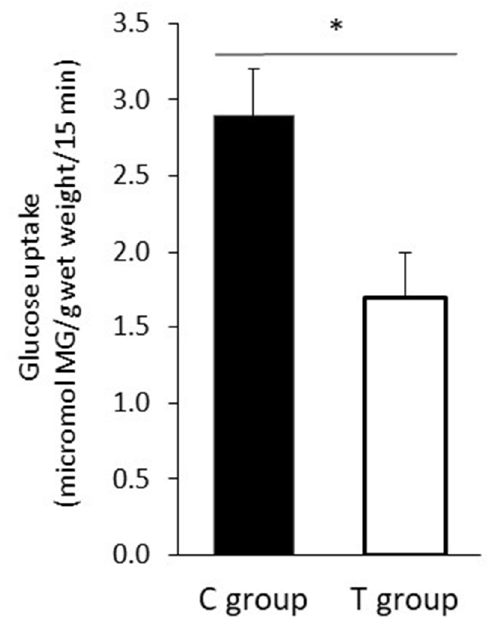
Figure 5. Intestinal glucose uptake. When intestinal glucose transport was determined, it was found that animals administered the FFP (T group) exhibited statistically significant lower marked glucose uptake compared to animals in C group (1.7 ± 0.7 versus 2.9 ± 0.6 micromol MG g wet weight −1 15 min −1 ; p = 0.029); ( n = 4 in C group and n = 5 in T group). Results are expressed as mean ± SD. * p <